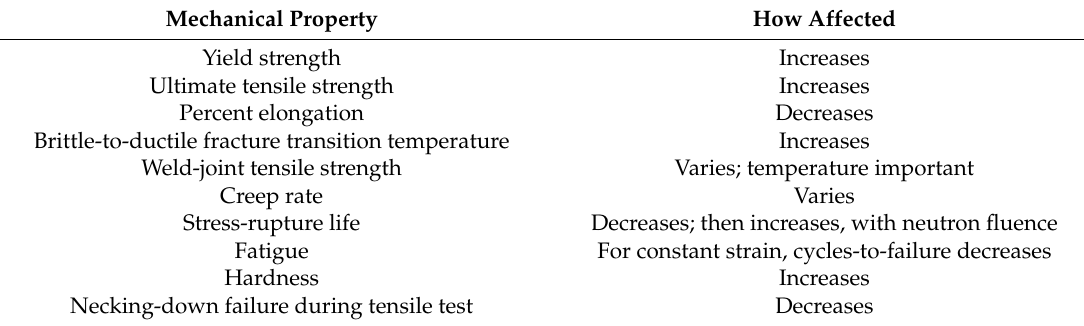
Table 2. Summary of radiation effects on metals [16].